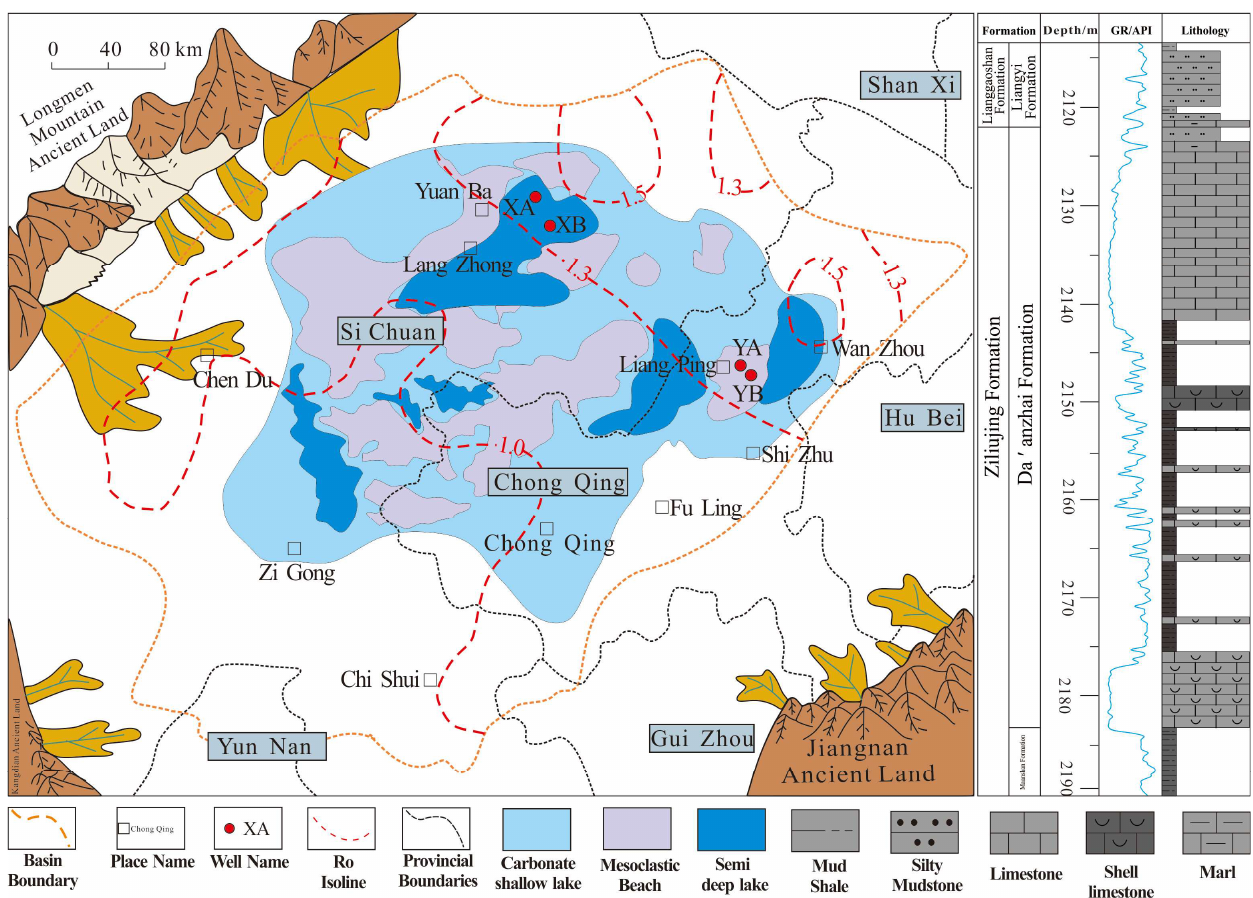
Figure 1. Sedimentary and distribution characteristics of the Jurassic Ziliujing Formation in the Sichuan Basin.